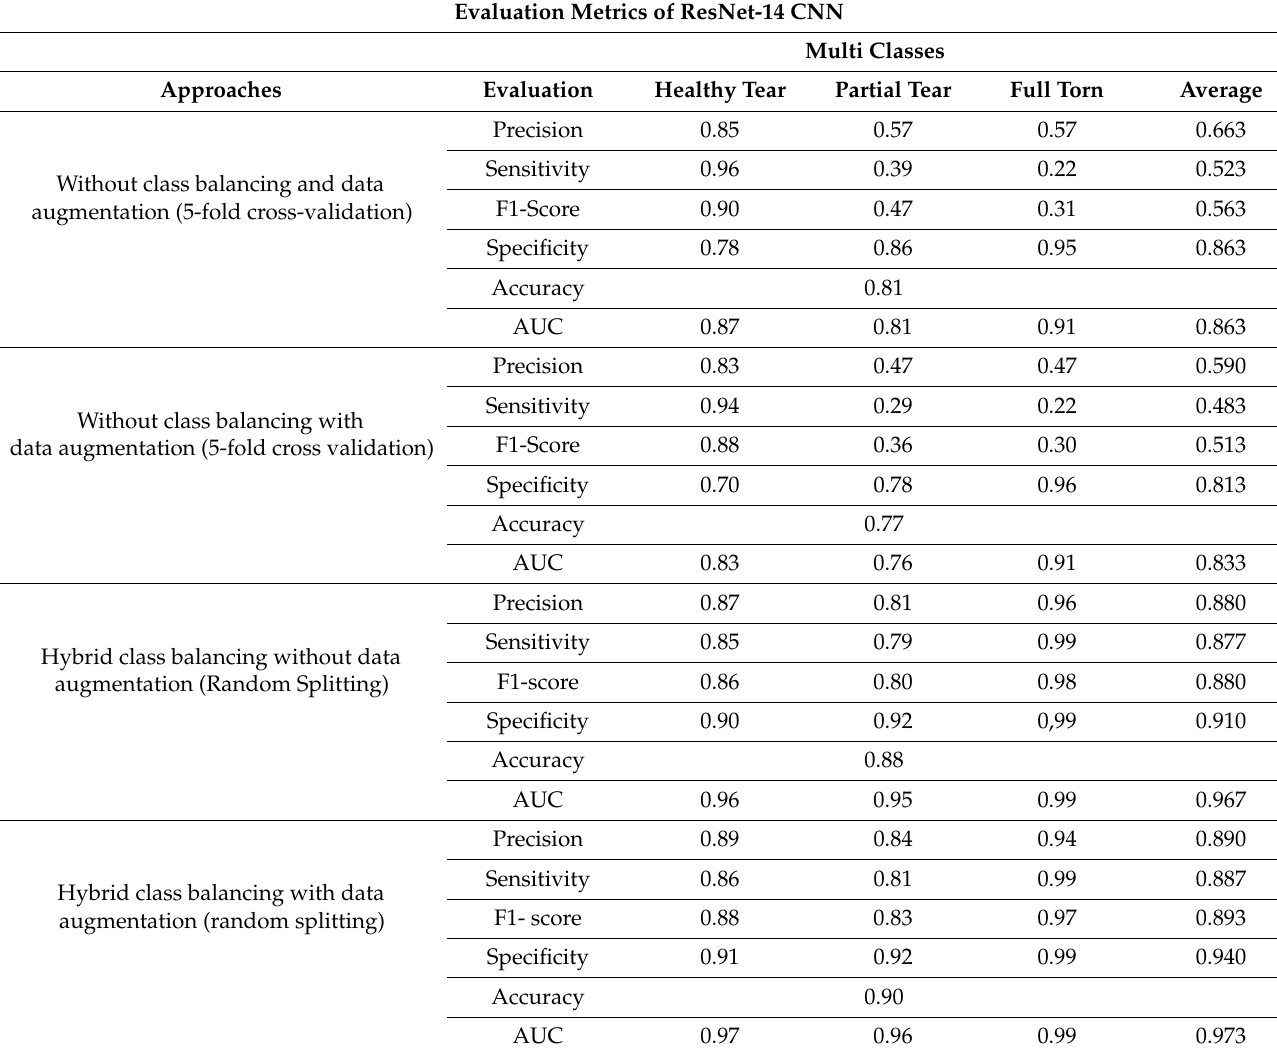
Table 6. Performance Metrics of model ResNet convolutional neural network